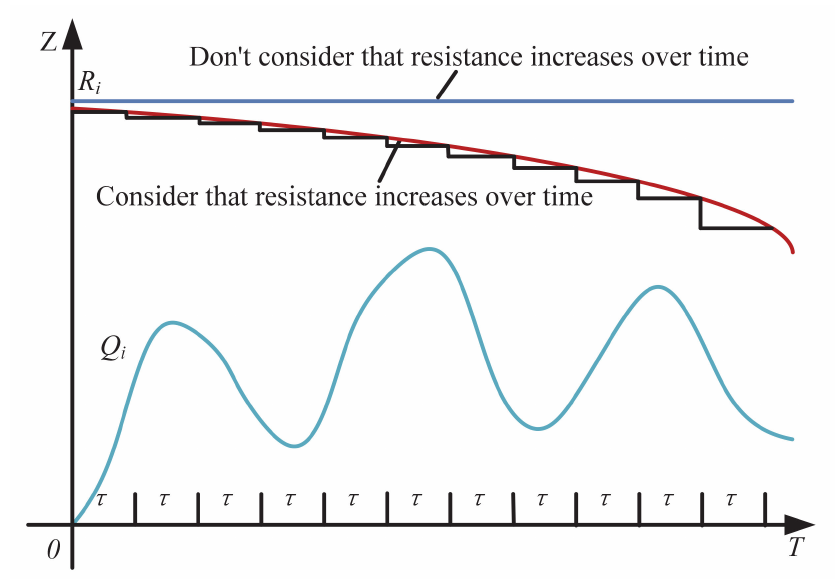
Figure 1. Distribution of resistance R ( t ) and variable load Q ( t ) over